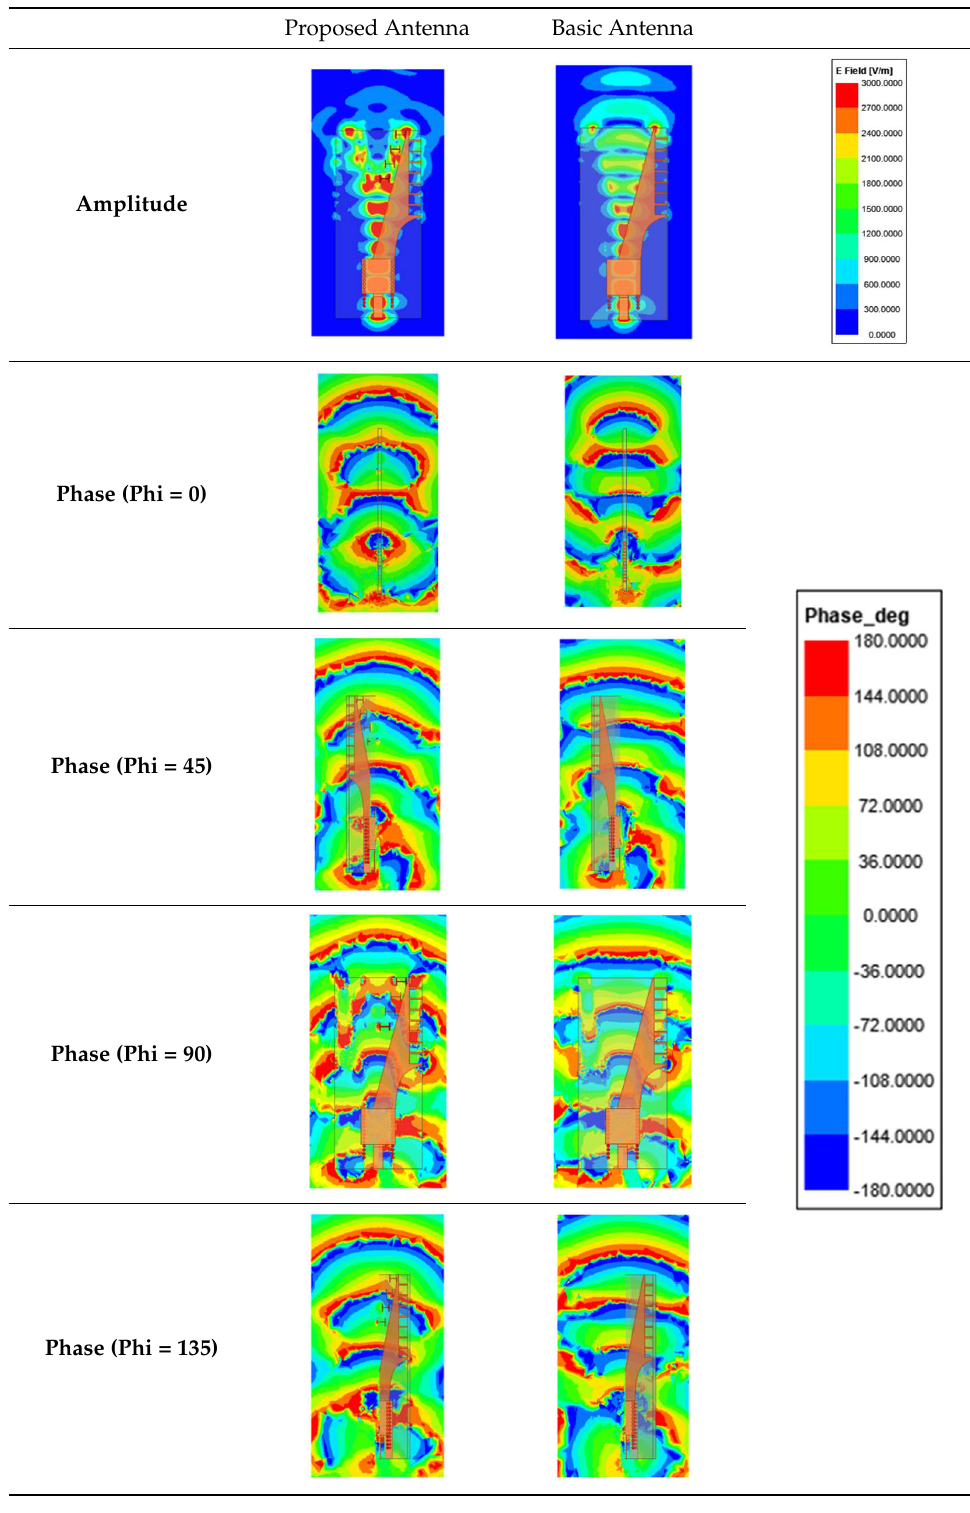
Table 2. E − field amplitude and phase distributions of the proposed and basic antennas. Table 2. E−field amplitude and phase distributions of the proposed and basic antennas. Table 2. E−field amplitude and phase distributions of the proposed and basic antennas. Table 2. E−field amplitude and phase distributions of the proposed and basic antennas. Proposed Antenna